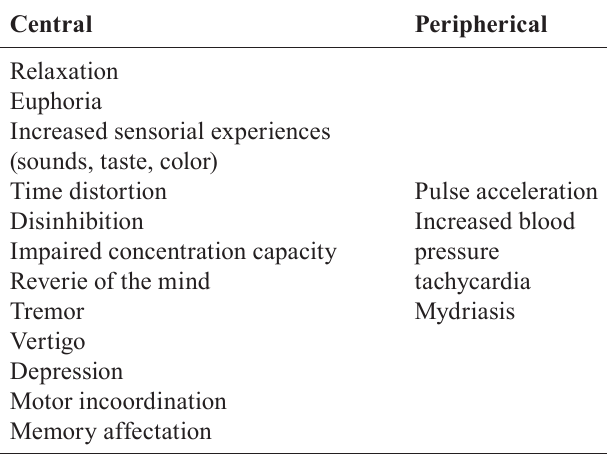
TABLE VII - Acute pharmacological effects of recreative smoke use of Cannabis (Abuhasira, Shbiro, Landschaft,